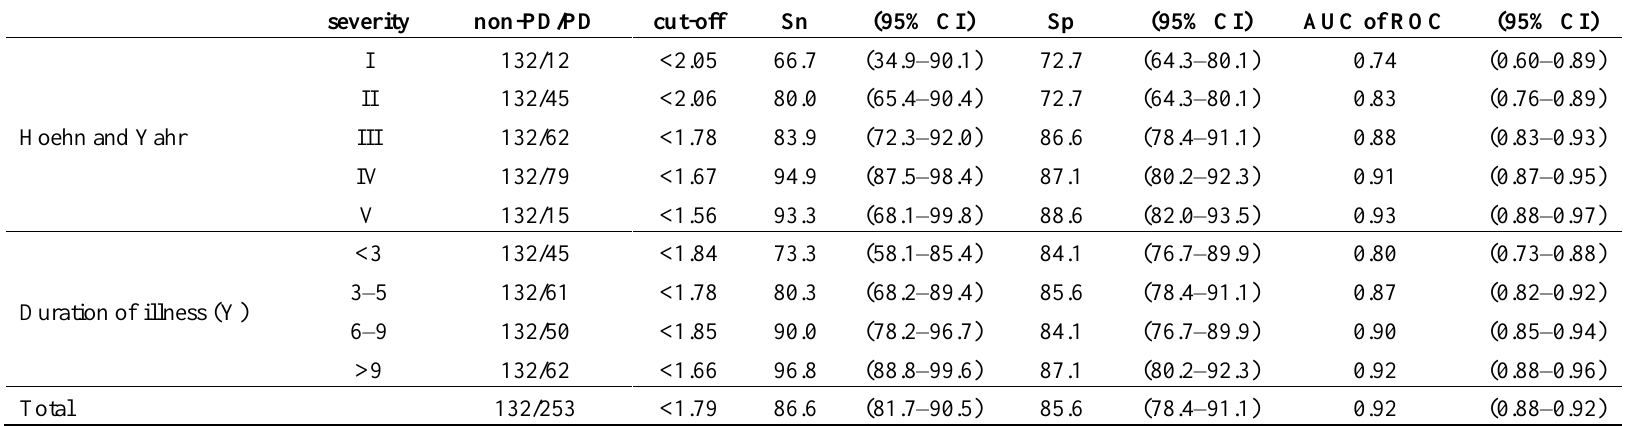
Table 2. ( B ) Diagnostic significance of late H/M of diagnosis of